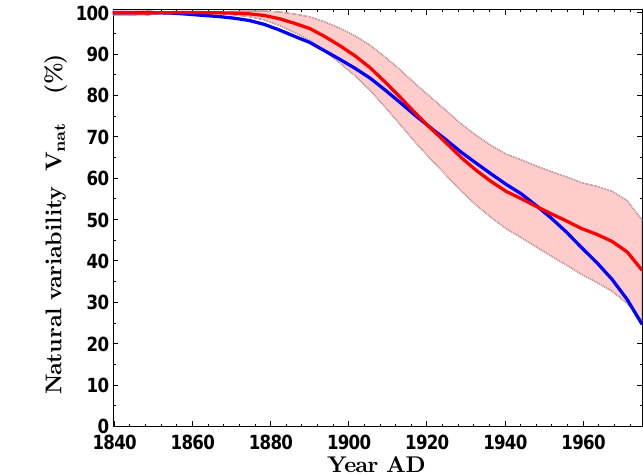
Fig. 6. Total δ 18 O SSA-AR forecast y pred ( t ) (red curve) for the Industrial Era and observed LFV values y LF ( t ) (black curve) over the entire 2200 yr covered by our record. Both y pred ( t ) and y LF ( t ) represent the climatic LFV recorded in the δ 18 O of core GT90/3, namely the ten leading RCs; for consistency, the mean δ 18 O value has been added back in (see Eq. 1). Pink shading: forecast error of the total SSA-AR forecast, based on the five forecasts of the narrow- band signals (see Fig. 5); and blue curve: sum of the narrow-band- signal forecasts obtained by neural-network prediction; see text for details.